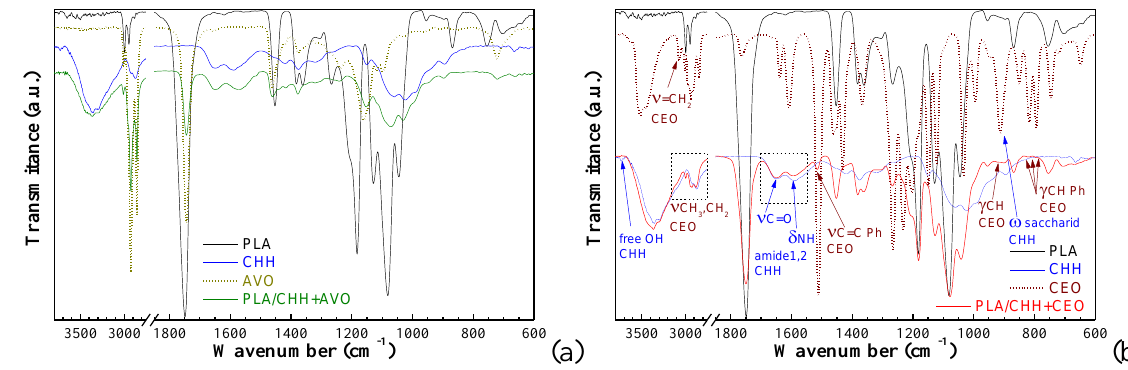
Figure 2. FTIR spectra of plasma treated PLA surface modified with chitosan coatings loaded with argan oil ( a ) and clove oil ( b ).